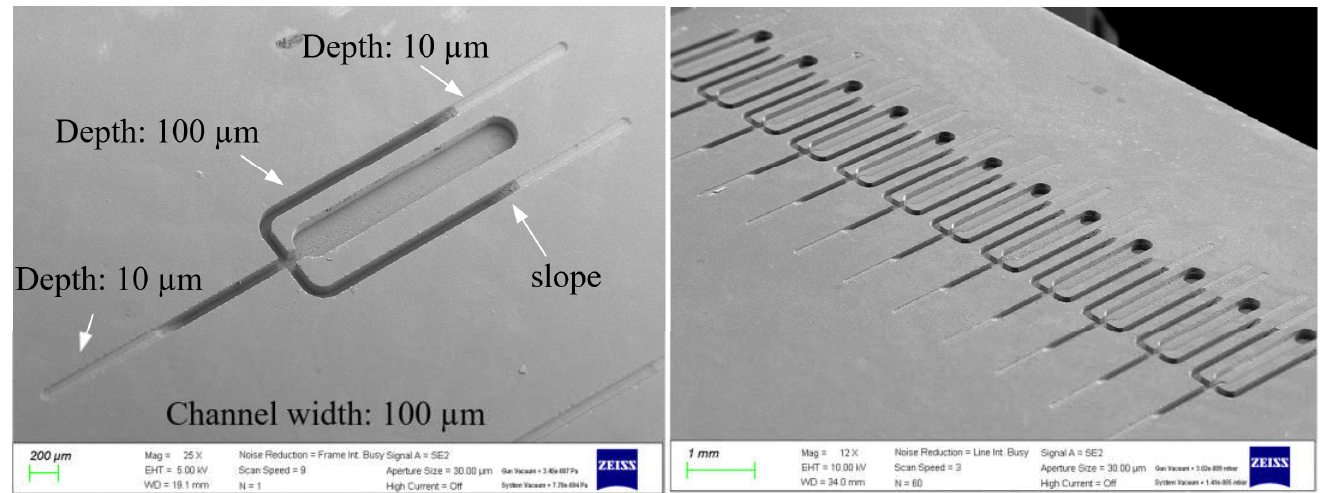
Figure 13. SEM images of channels with different slopes and depths.